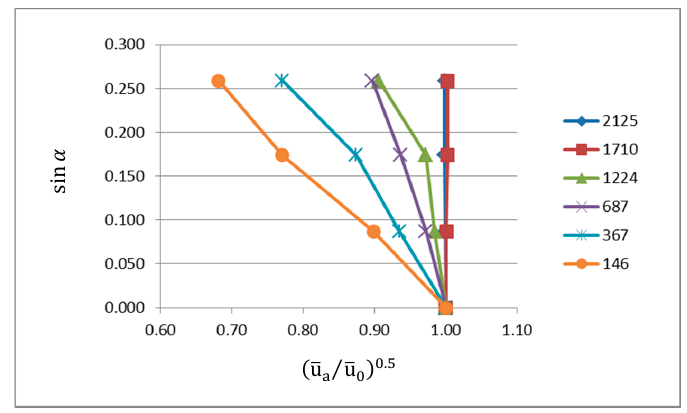
Figure 8. Jet angle influence.